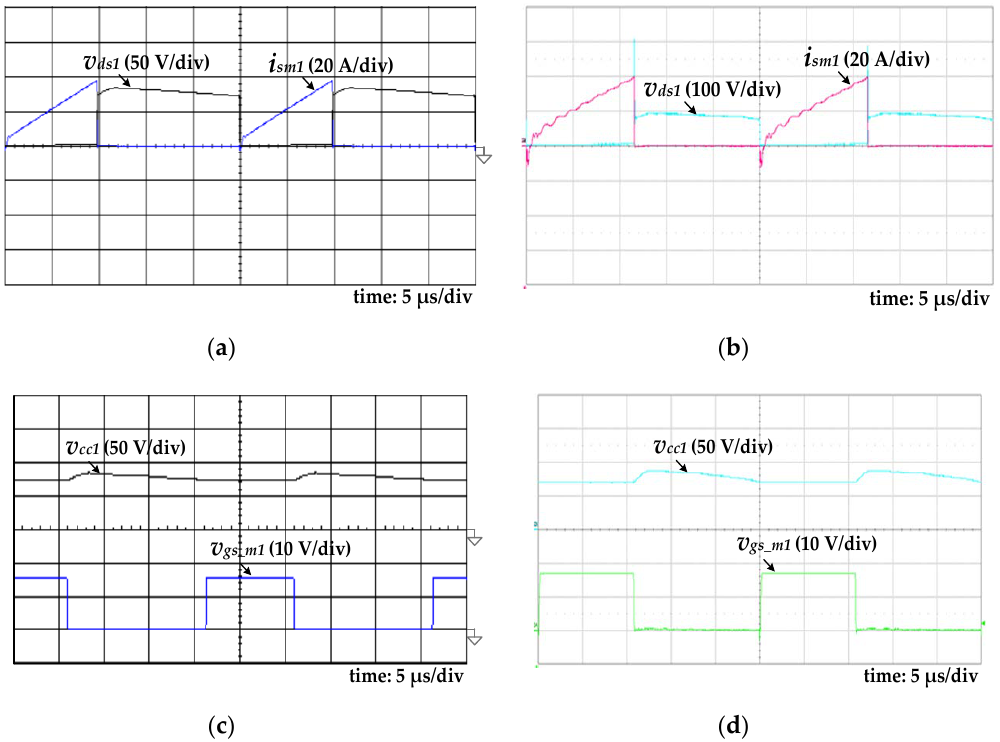
Figure 10. Measured waveforms of output voltage v o and output current i o when the inverter is operated with a step-load change of ( a ) from 320 W to 160 W; ( b ) from 160 W to 320 W.